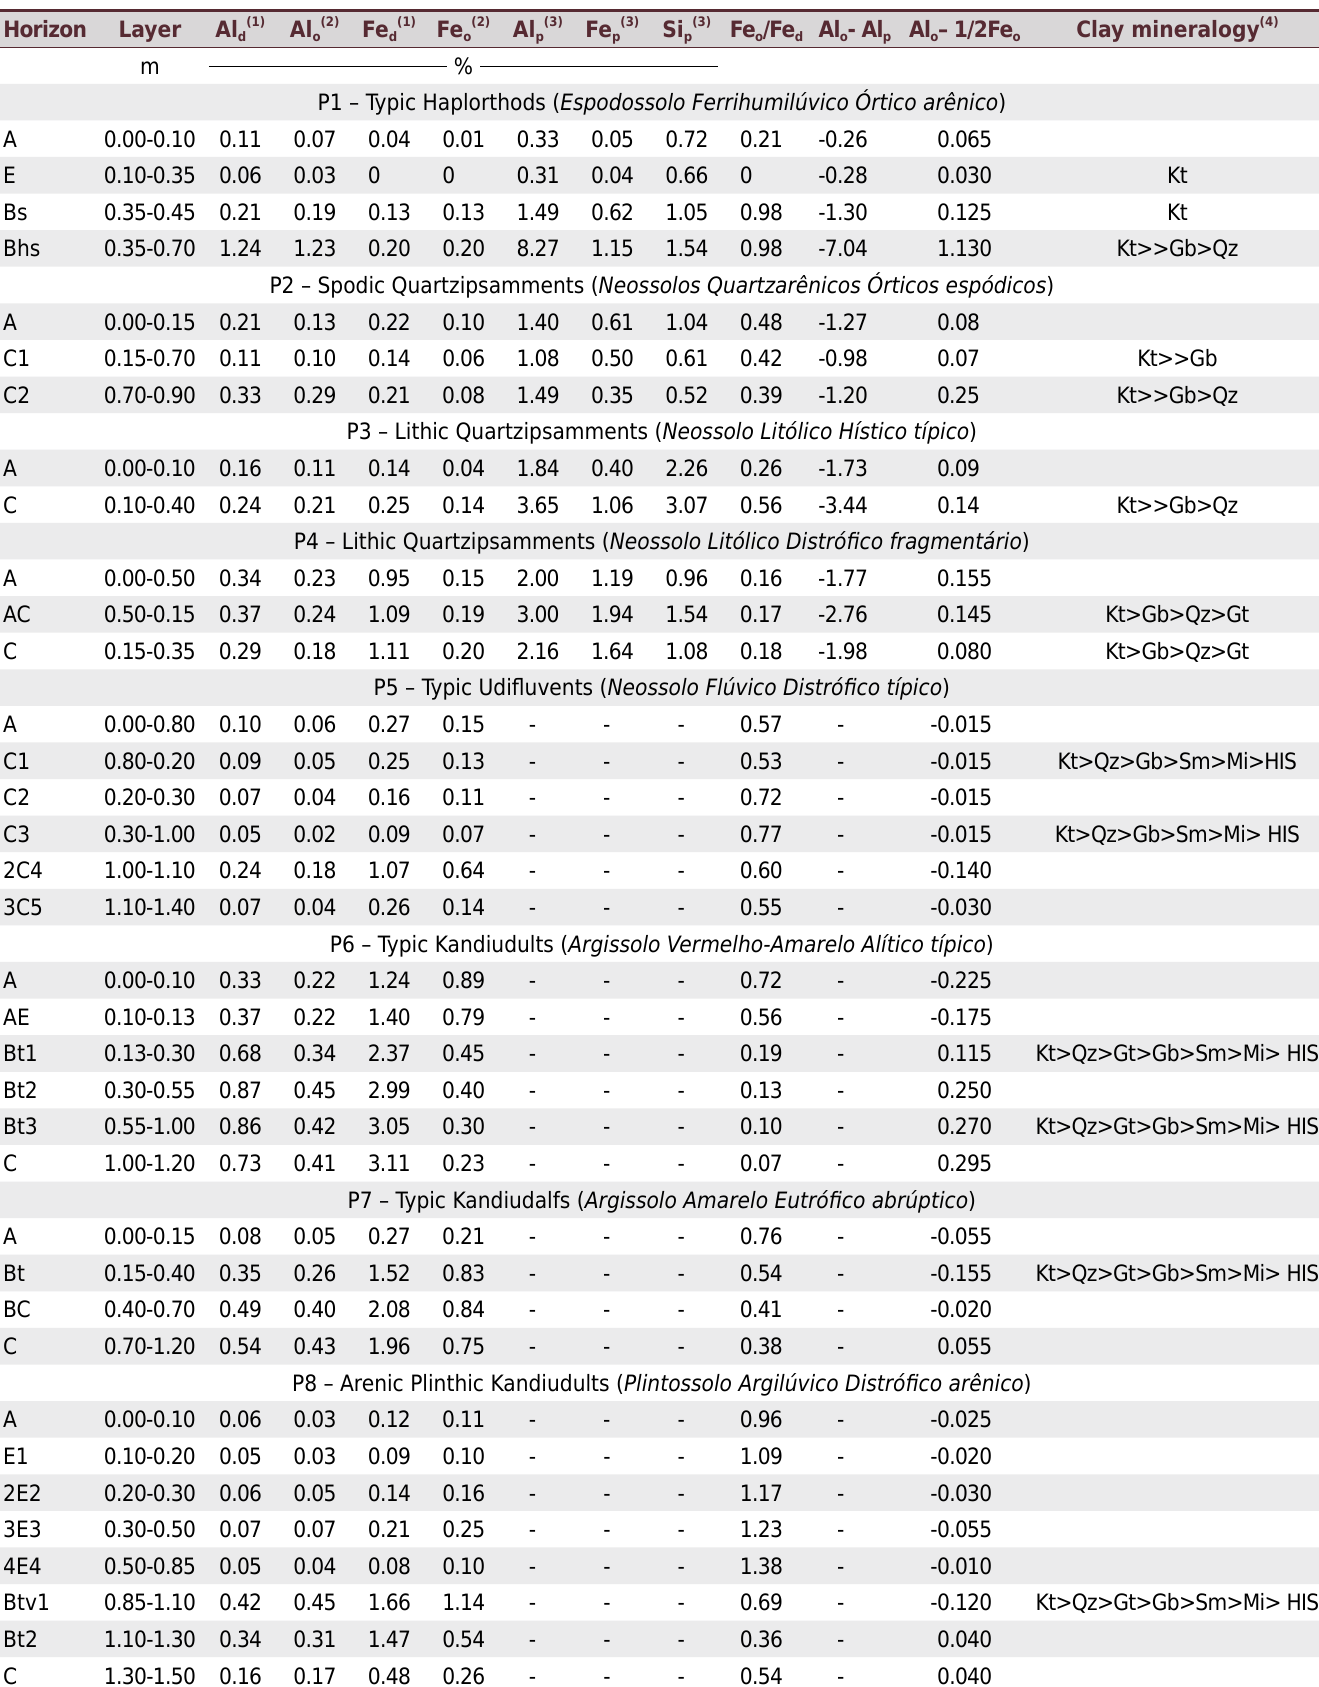
Table 5. Clay mineralogy by DRX, Al d , Al o , Al p , Fe d , Fe o , Fe p , Si p , and some ratios of the studied soils Horizon